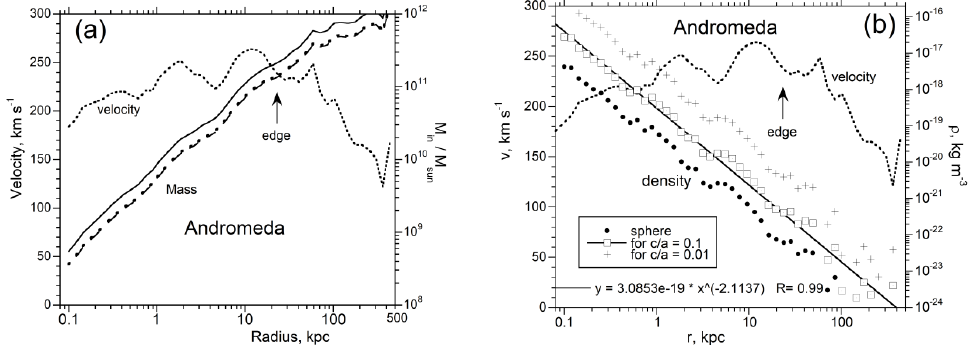
spaced dotted lines. Results of fitting are listed. For size comparisons, we use the visual edge at 25